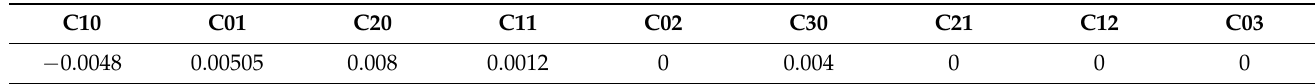
Table 2. Hyperelastic properties of the periodontal ligament. The Mooney – Rivlin constitutive equation was used with the listed constants.